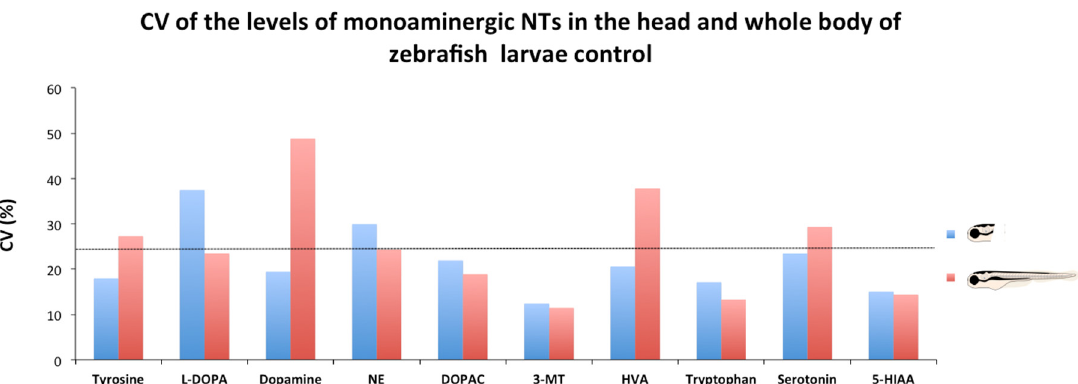
Figure 4. Analysis of the variability of the determination of neurochemicals in the head and the whole body of control larvae. Coefficient of variation was used for determining the variability of the concentrations of the monoaminergic neurochemicals determined in the head and the whole body.